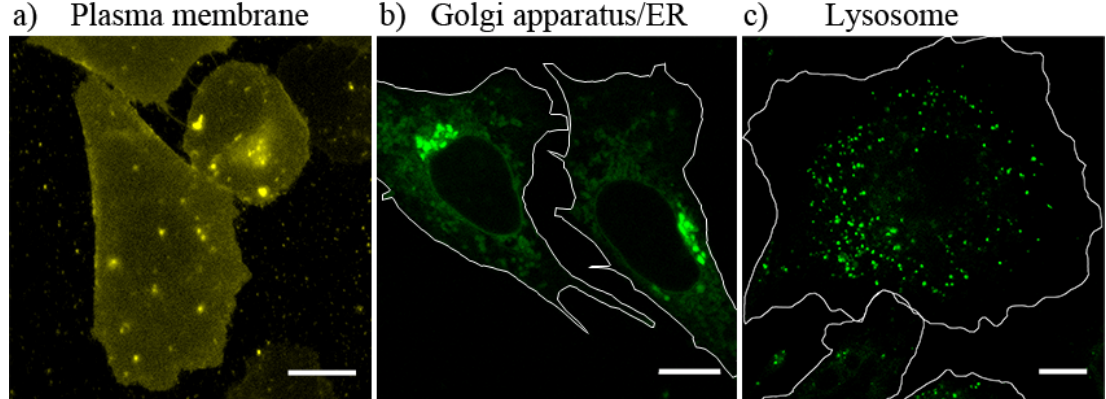
(a) Cellular plasma membrane of CHO-K1 cells was stained using Vybrant-DiI; (b) Golgi apparatus and endoplasmic reticulum staining were verified by Bodipy FL-ceramide-BSA incorporation;